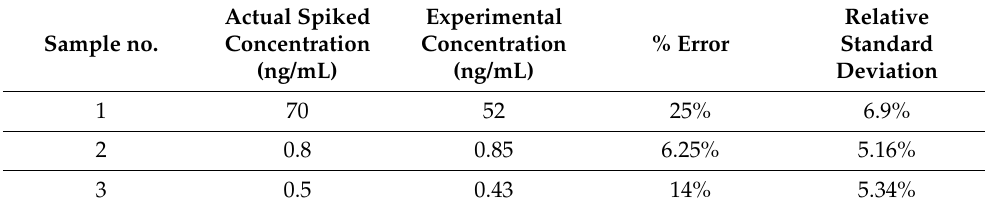
Figure 7. Cyclic voltametric response of the fabricated immunosensor towards the serum samples spiked with various concentrations of cTnI. spiked with various concentrations of cTnI. Table 2. Detection of cTnI in Serum Samples. Table 2. Detection of cTnI in Serum